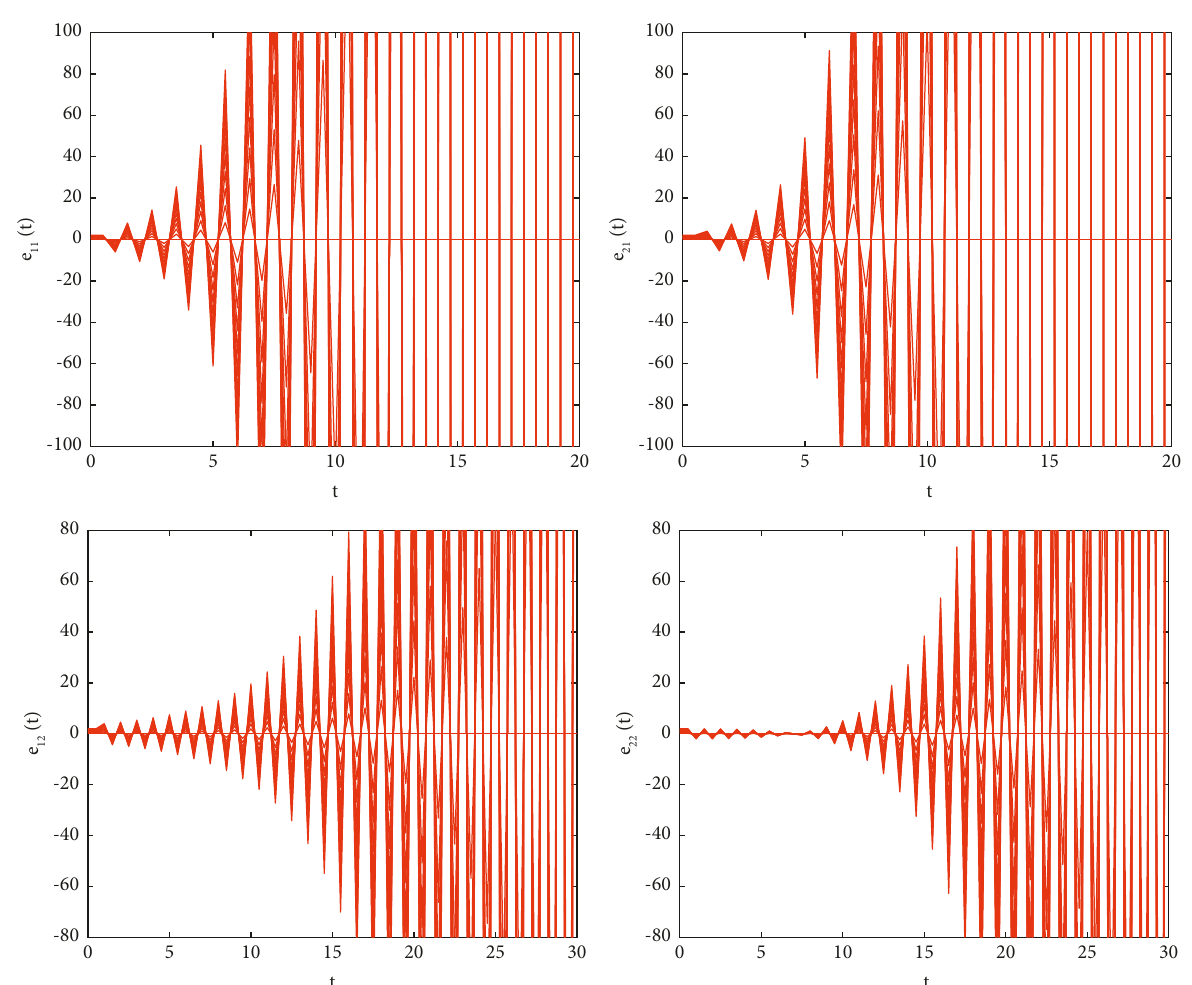
Figure 6: The instable behavior of error system (86) with ρ � 1 / 2 under a nonlinear control